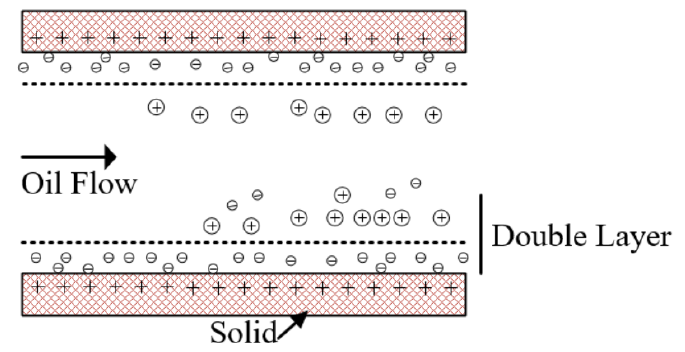
Figure 11. The Double Layer in the interface of the tube and oil.